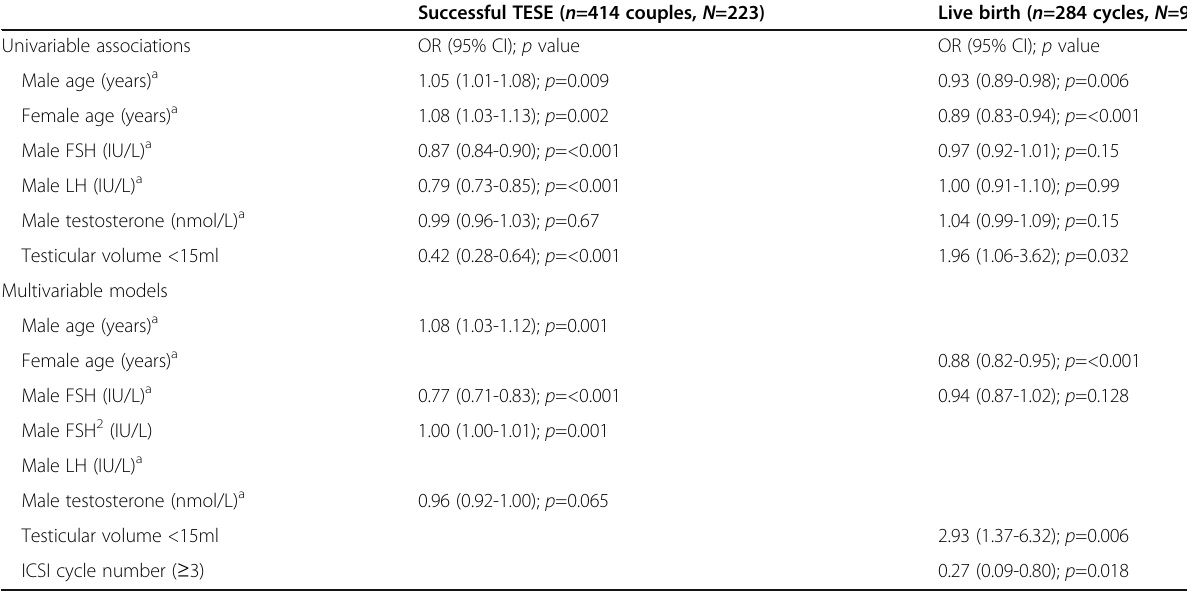
Table 3 Univariable associations and multivariable associations with successful TESE and live birth Successful TESE ( n =414 couples, N =223) Live birth ( n =284 cycles, N =91) Univariable associations OR (95% CI); p value OR (95% CI); p